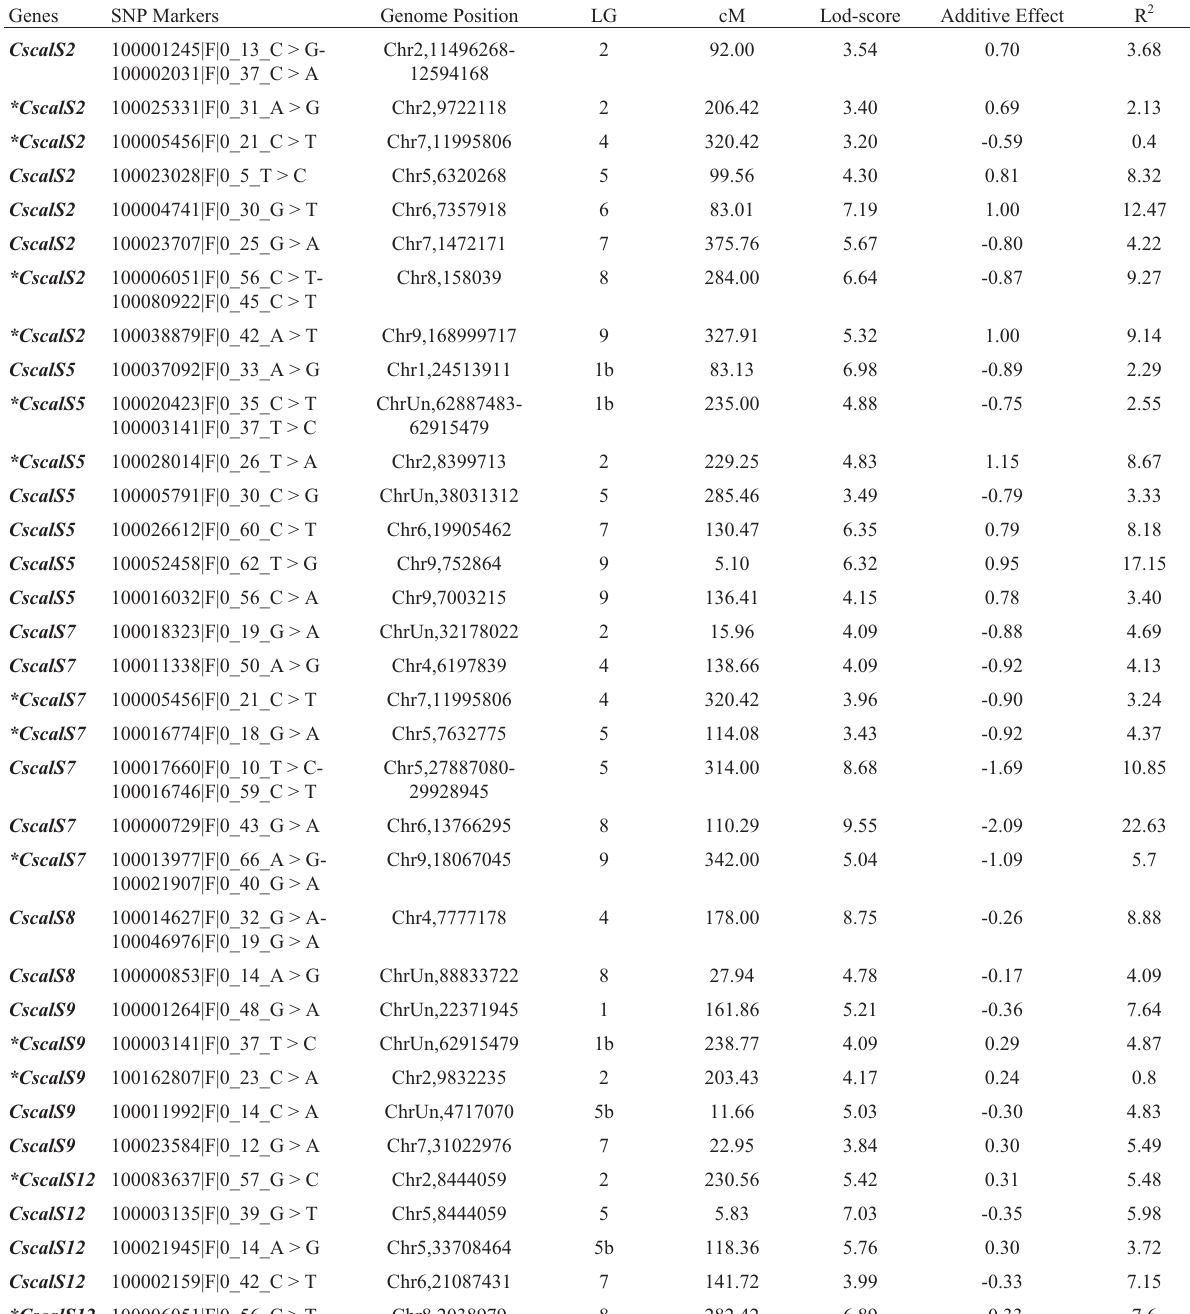
Table 5 - eQTL mapped for CscalS 2, CscalS 5, CscalS 7, CscalS 8, CscalS 9, CscalS 12 in the P. trifoliata linkage map.